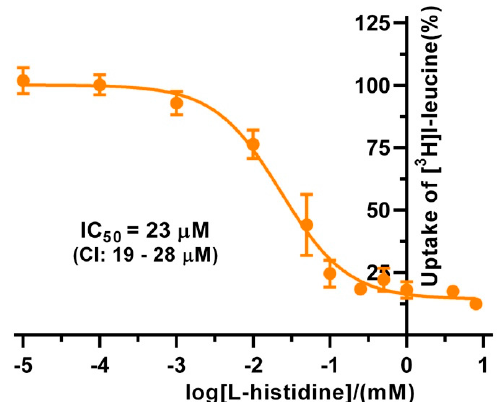
Figure 4. IC 50 determination of L-histidine for human 4F2hc-LAT1 transporter. The determined IC 50 value for 4F2hc-LAT1 transporter is 23 µM (95% confidence interval (CI): 19–28 µM). For data analysis, the signal of the untransformed P. pastoris KM71H was subtracted from 4F2hc-LAT1 transporter. Cpm values of each experiment were normalized with respect to the determined upper plateau value, i.e., the fitted upper plateau value corresponds to 100%. A sigmoidal model curve (orange) was fitted to the net transport signals to obtain the IC 50 . Data points represent means with SD from normalized data of three independent experiments, each at least in triplicate are shown. If not visible, error bars are smaller than symbols.